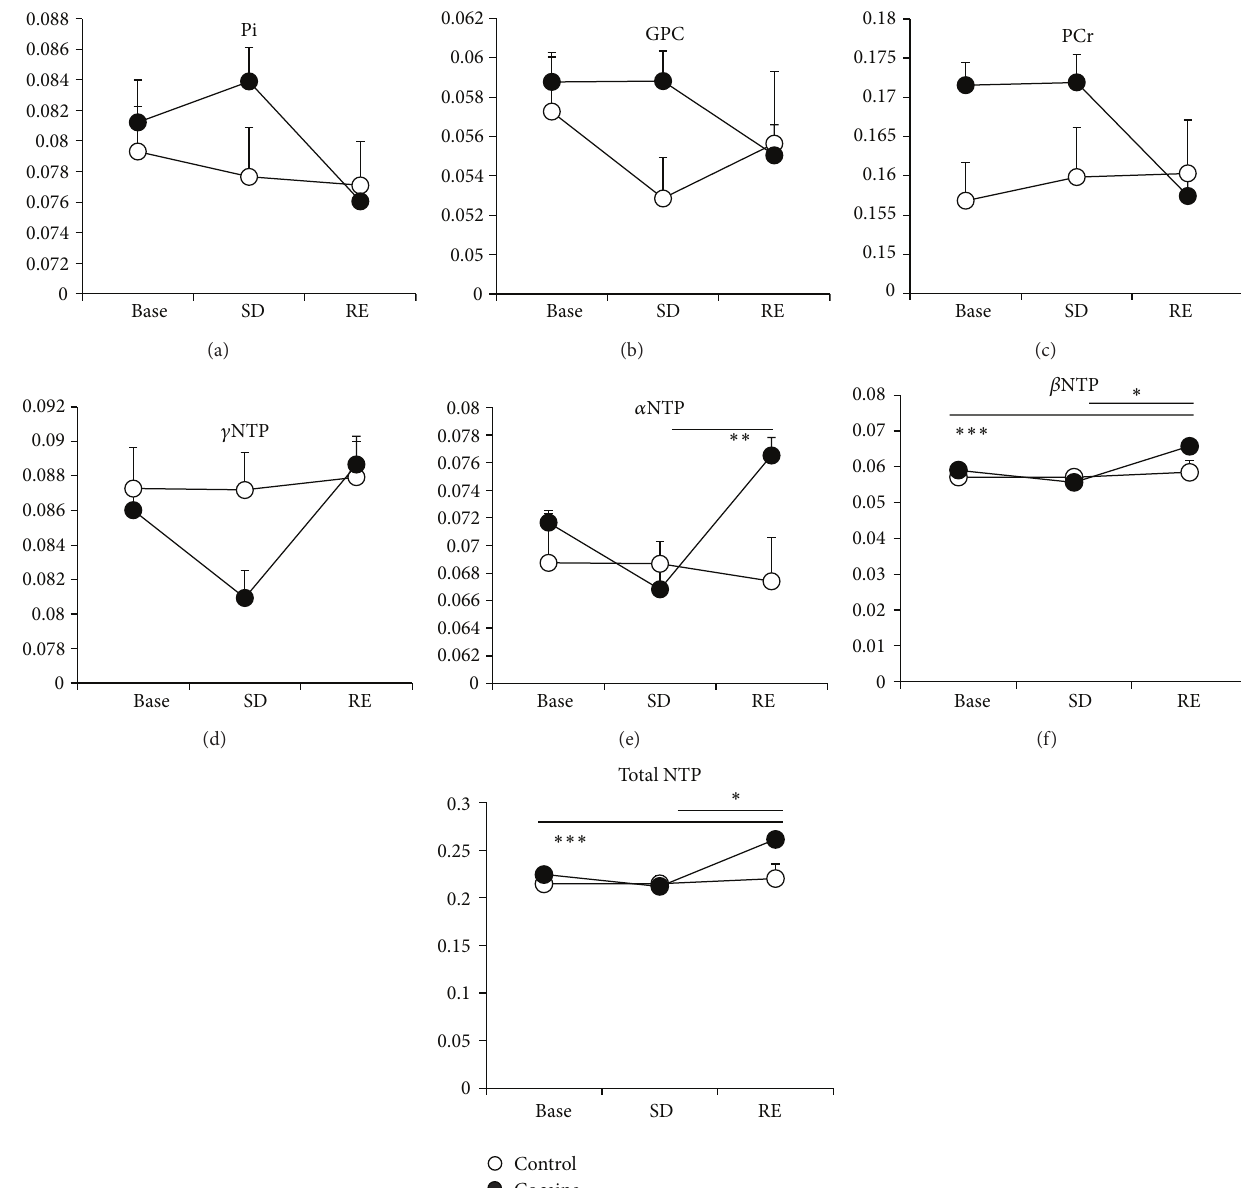
Figure 2: [31] P MRS global brain expression of inorganic phosphate (Pi; (a)), glycerophosphocholine (GPC; (b)), phosphocreatine (PCr; (c)), 𝛾 -nucleoside triphosphate ( 𝛾 -NTP; (d)), 𝛼 -NTP (e), 𝛽 -NTP (f), and total NTP (g) in healthy control (control) and cocaine-dependent